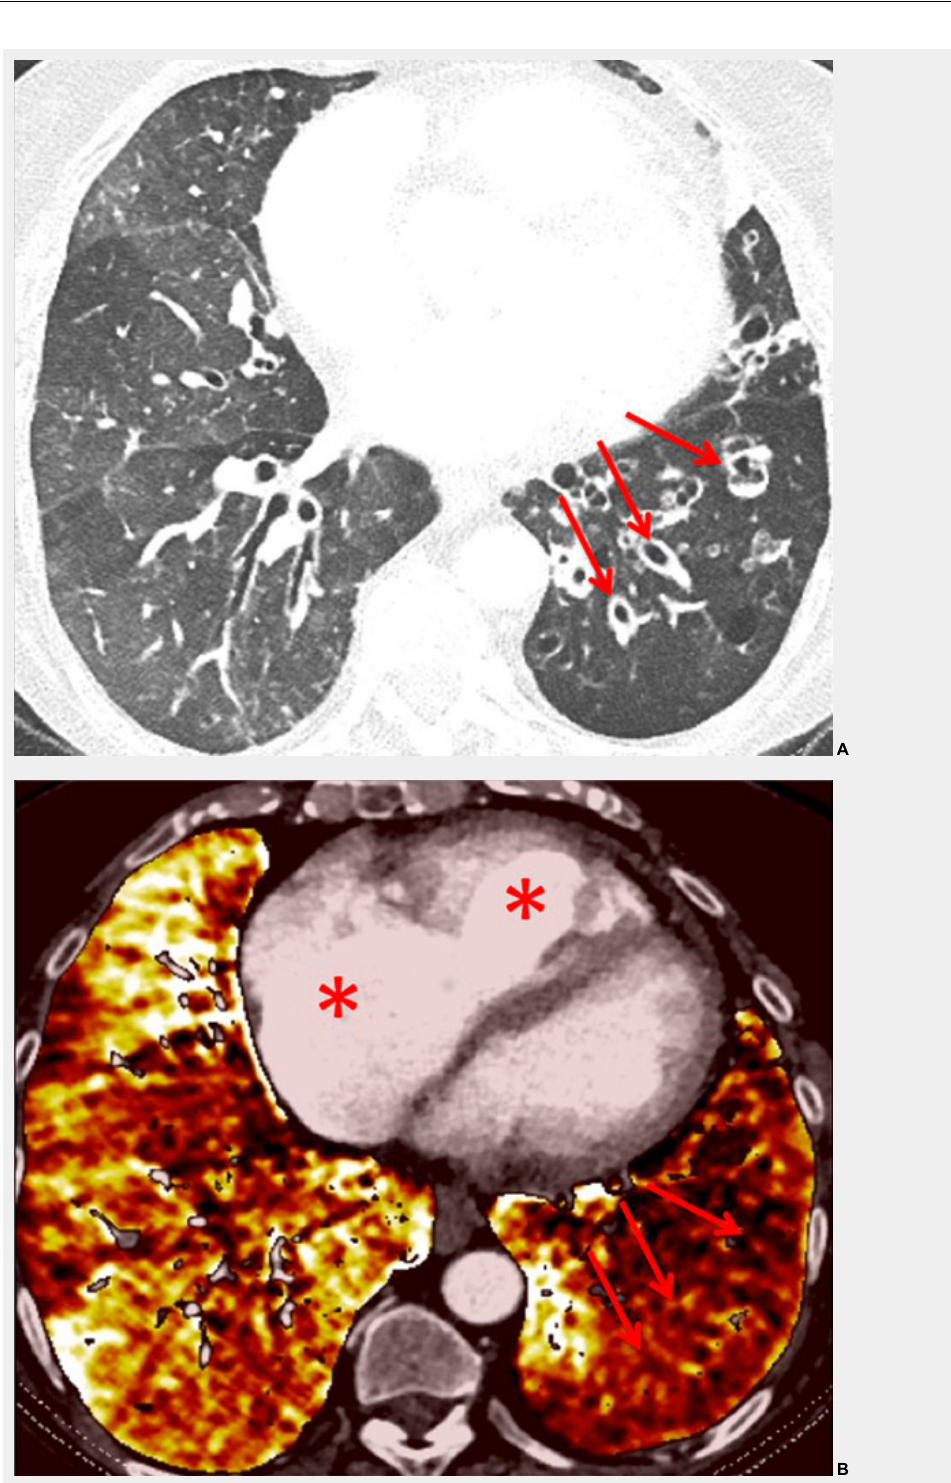
Figure 10 Severe bronchopathy (arrow) in the left lower lobe ( A ) associated with extended hypoperfusion (arrow) and dilatation of the right cardiac cavities (stars) ( B